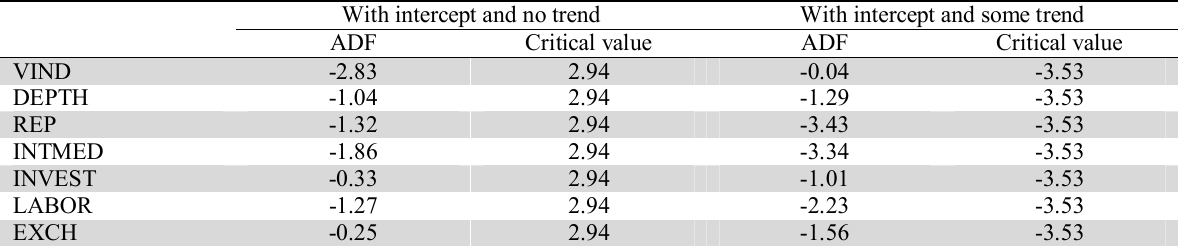
The summary of augmented dickey fuller test on independent variables for I(0) With intercept and no